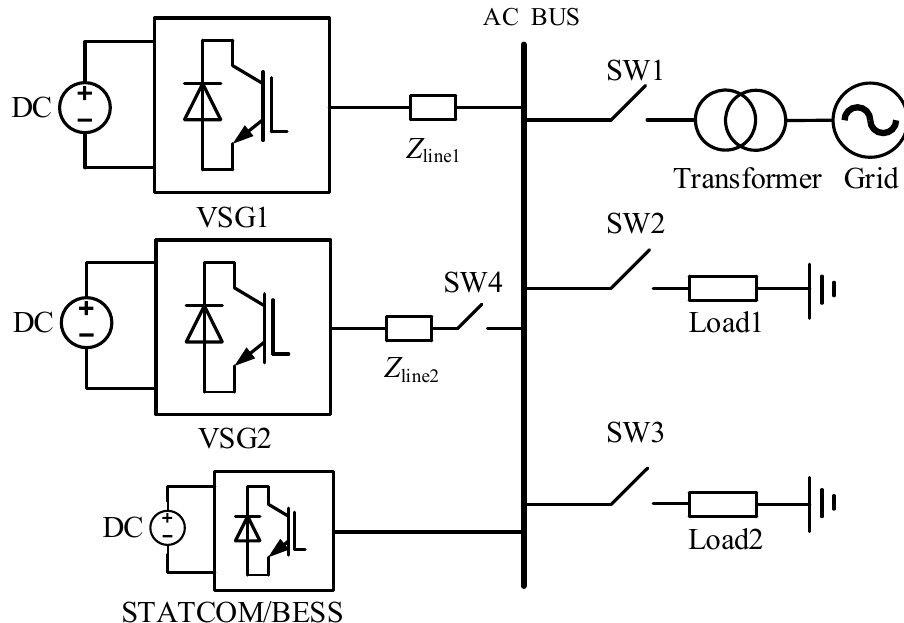
Figure 6. Structure diagram of simulation platform.